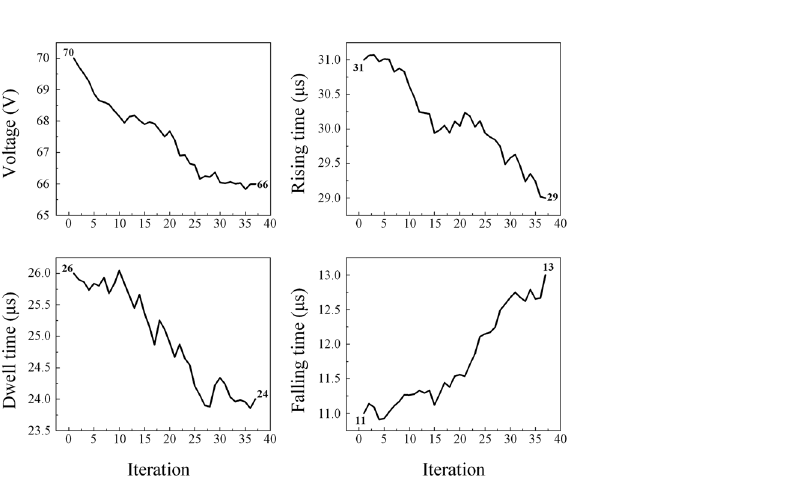
Figure 6. ( a ) Sequence images of drop formation at an initial waveform and ( b ) an optimized waveform from the proposed method. Scare bar: 100 μm.